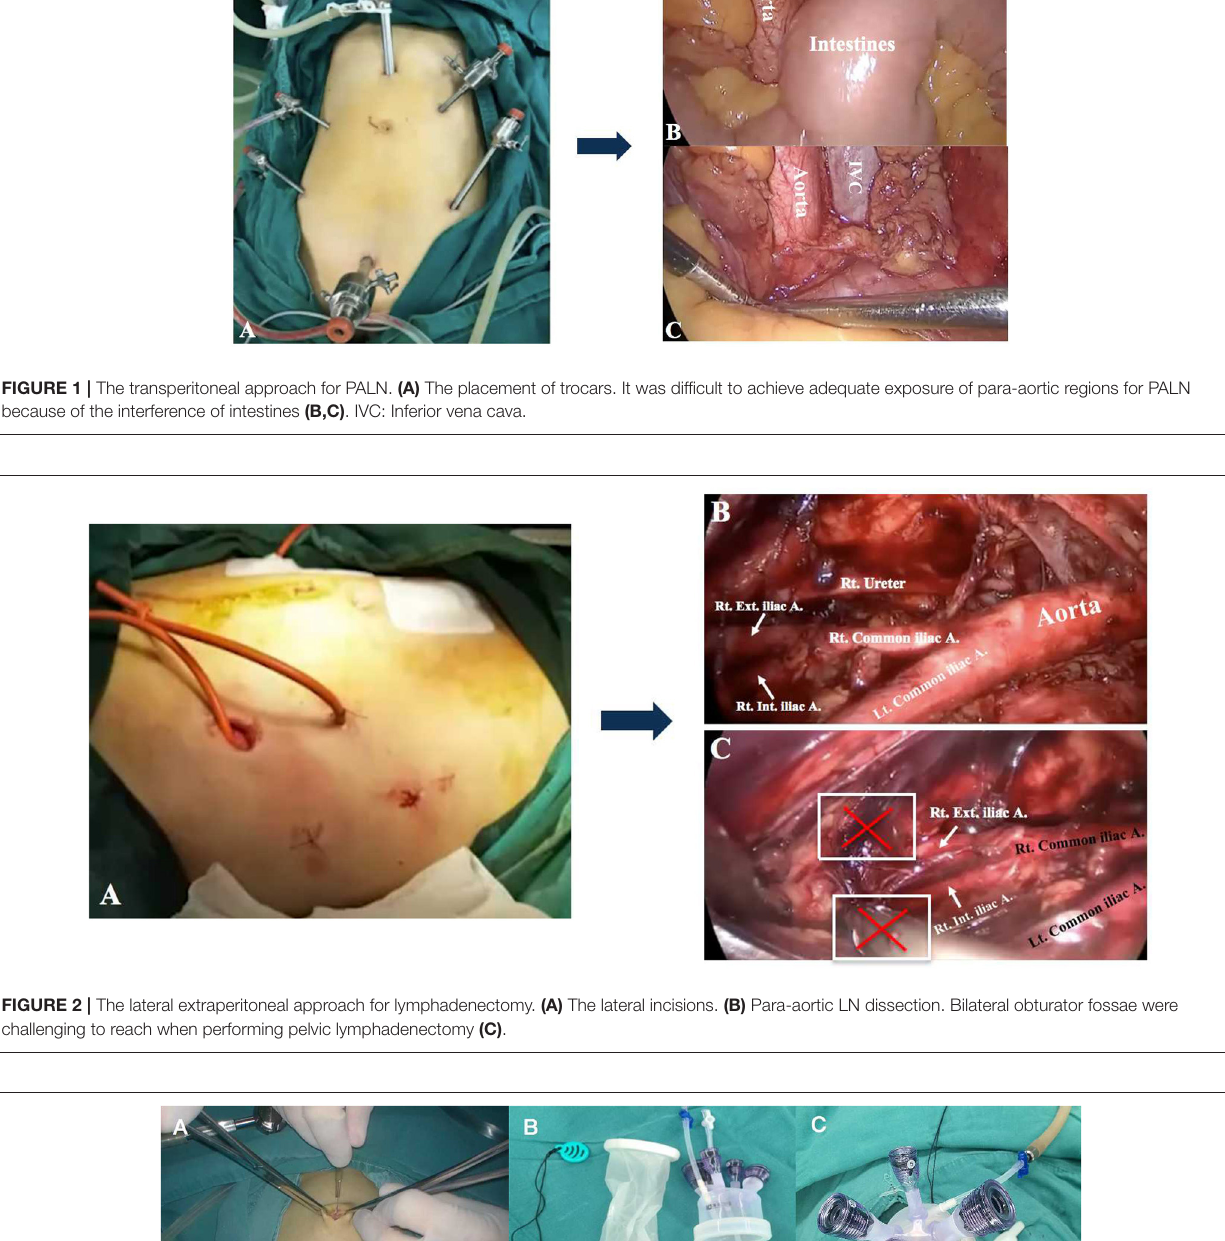
portion of the suspended posterior peritoneum was gently sliced open ( Figure 4 , Supplementary Video 1 ). The third step was to separate the extraperitoneal soft tissues that attached to the